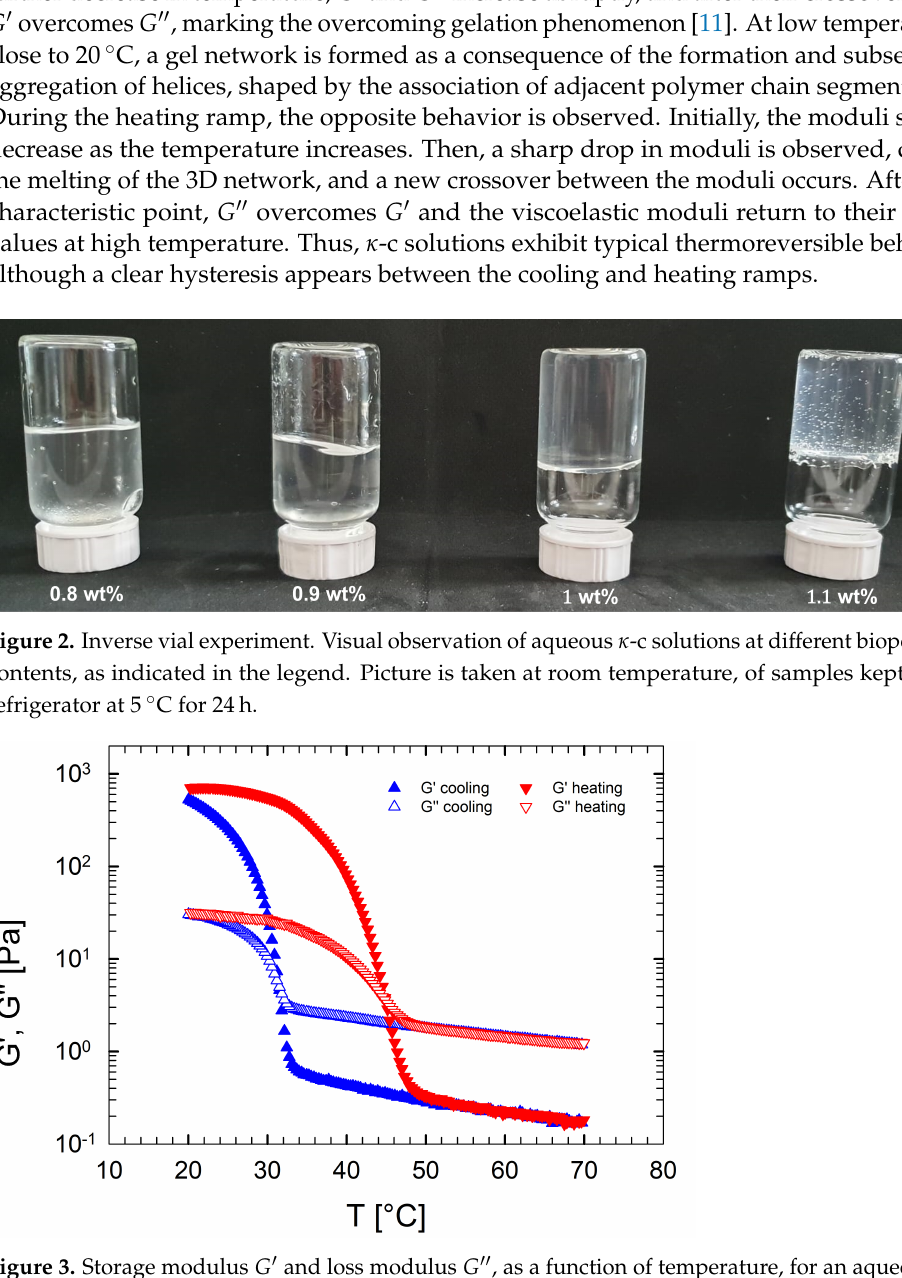
Figure 3. Storage modulus G (cid:48) and loss modulus G (cid:48)(cid:48) , as a function of temperature, for an aqueous κ -c solution at 1.5 wt% and 1 ◦ C/min. Blue up-pointing triangle symbols indicate the cooling phase, red down-pointing triangle symbols, the heating